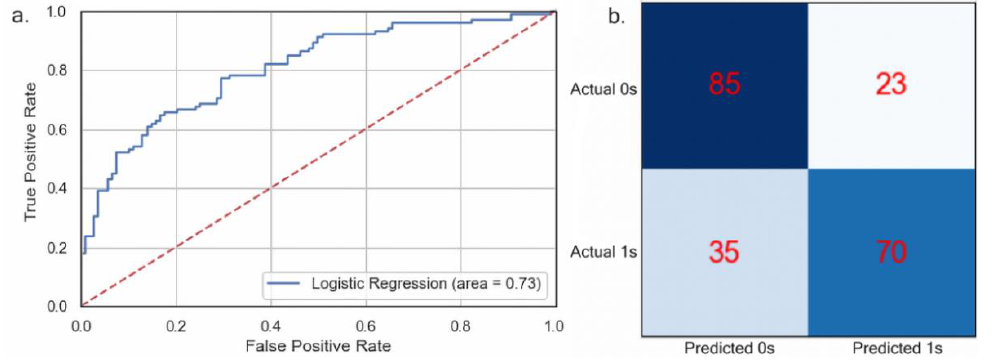
Figure 5. a . ROC performance; b . model confusion matrix. Figure 5. ( a ). ROC performance; ( b ). model confusion Table 5. Precision, recall and F-measure.